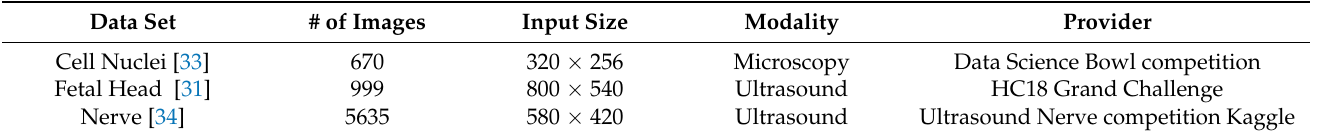
Table 1. Experimental data sets for image segmentation.